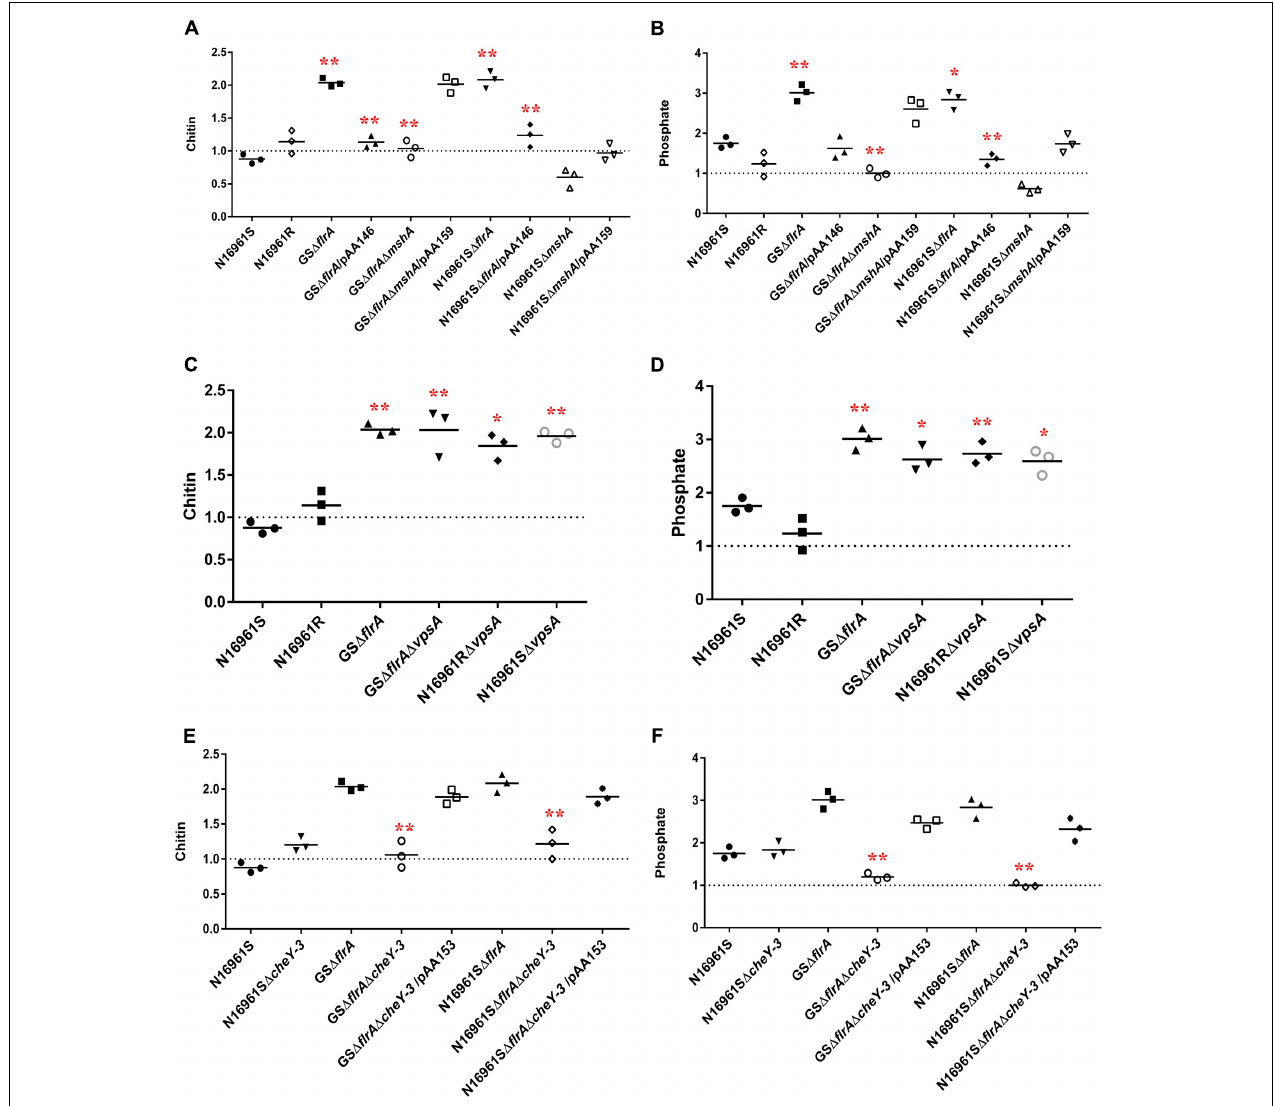
FIGURE 5 | vps -independent biofilm promoted V. cholerae to move toward nutrient sources in FSLW as measured by chemotaxis. Chemotaxis assay was performed on V. cholerae strains as described previously (Butler et al., 2006) with modifications. Briefly, assay was performed in nutrient-deficient FSLW or FSLW supplemented with nutrients, including chitin or phosphate. The results represent three independent experiments and the data were expressed as a comparative index (CI) for each strain. CI was calculated by the number of bacterial counts (colony forming units per milliliter) present in FSLW in the capillary tube supplemented with nutrient divided by the number of bacterial counts (colony forming units per milliliter) present in FSLW in the capillary tube not supplemented with nutrient. The horizontal bar indicates the mean of the results from three capillary tube experiments. The observations resulting from an experiment pointing at or below the dashed line reflect no measurable response between control (-nutrient) and experiment (+nutrient) for each strain examined. A p -value of < 0.05 was considered statistically significant. Impact of (cid:49) flrA and (cid:49) mshA mutants and reverted mutants on: (A) chitin and (B) phosphate; impact of (cid:49) cheY-3 mutants and reverted mutants on: